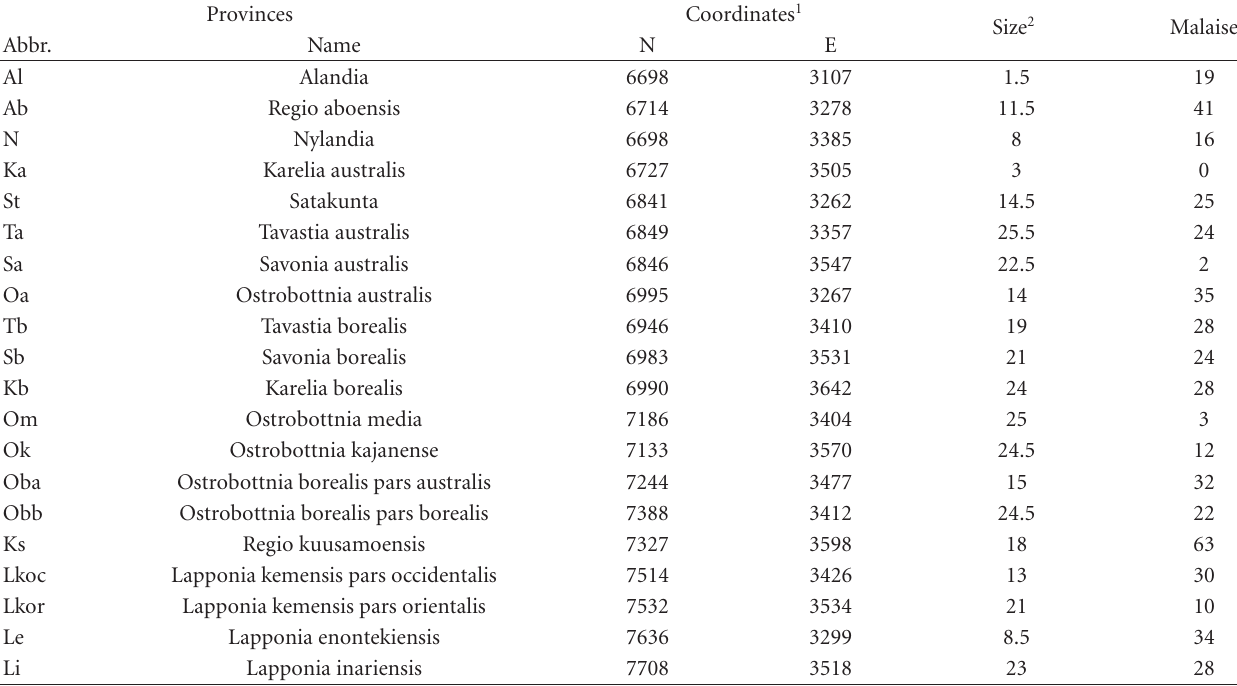
Table 1: Finnish biogeographical provinces, their abbreviations and full names, locations, sizes, and number of Malaise trapping sites during the years